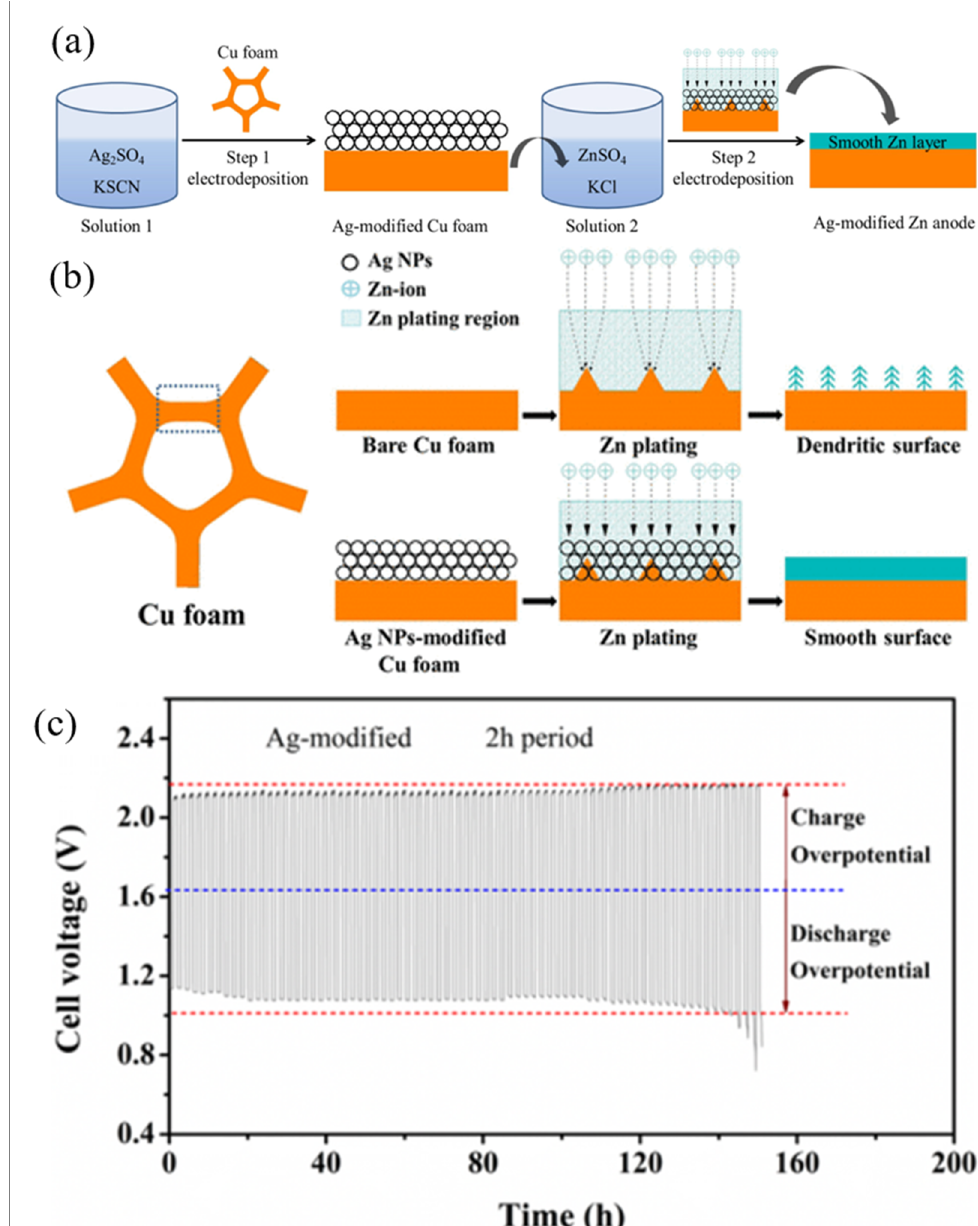
Figure 5. ( a ) Schematic representation of the construction method of Ag-modified 3D zinc anode, ( b ) schematic illustration of zinc deposition process on plain Cu foam and Ag-modified Cu foam and ( c ) the charge–discharge cyclic activity of zinc–air battery fabricated with Ag-modified zinc anode (2 h cyclic duration) [26]. Reprinted with permission from Ref. [26], Copyright 2019, American Chemical